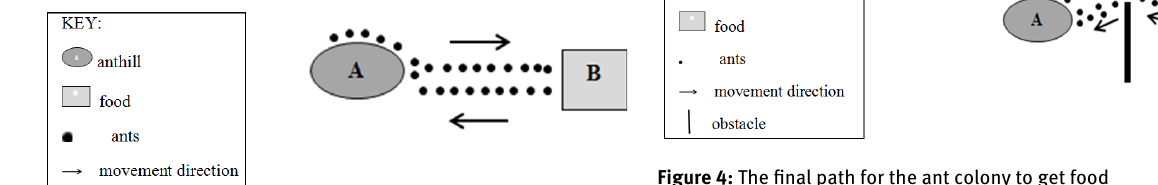
Individuals who choose a shorter route strengthen the pheromone trace, which settles on it faster than on the longer route, as on the shorter route less substance will evaporate as opposed to the second choice (Figure 3).